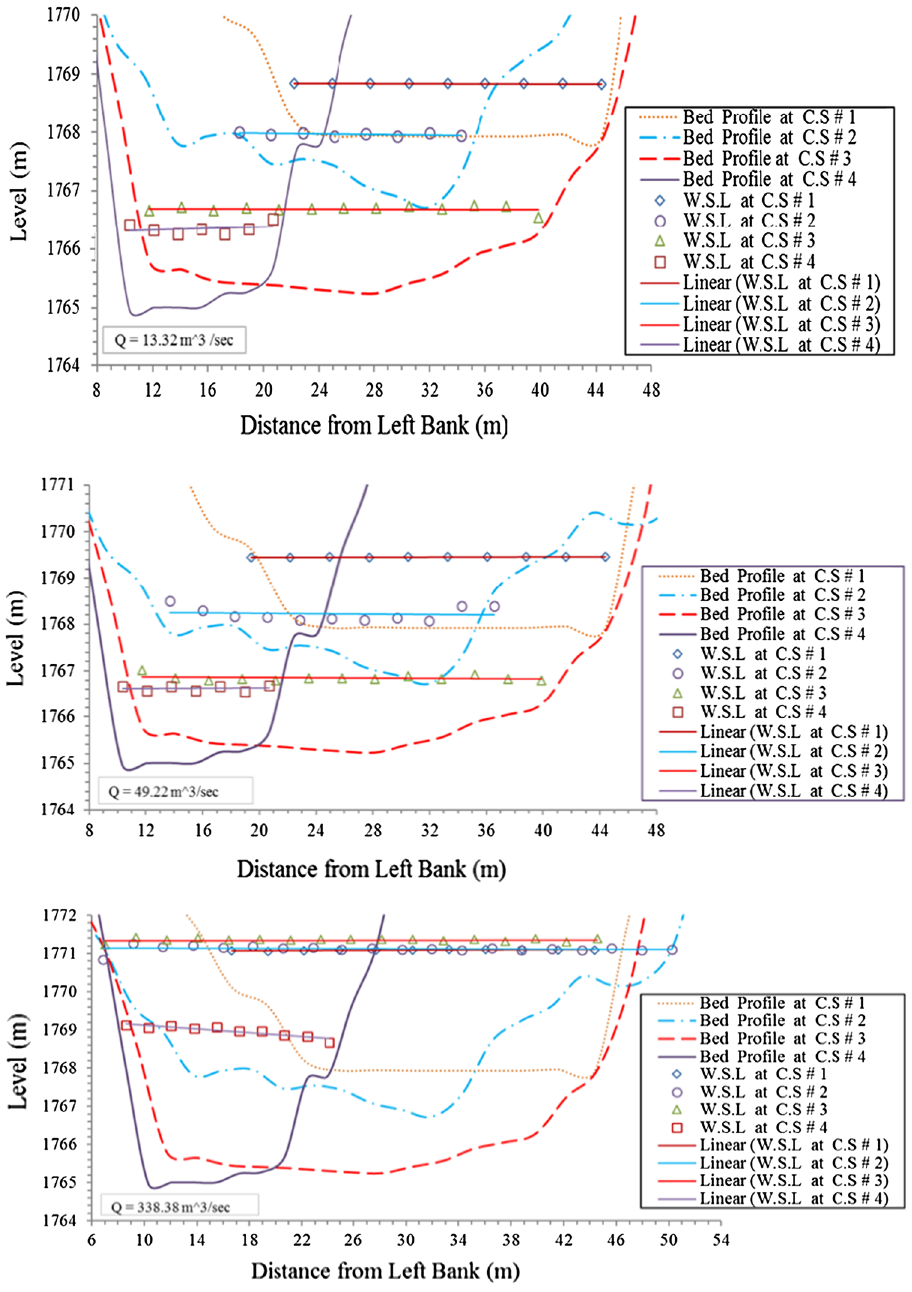
Fig. 9 Cross-profiles of water surface in the straight and sud- den contraction